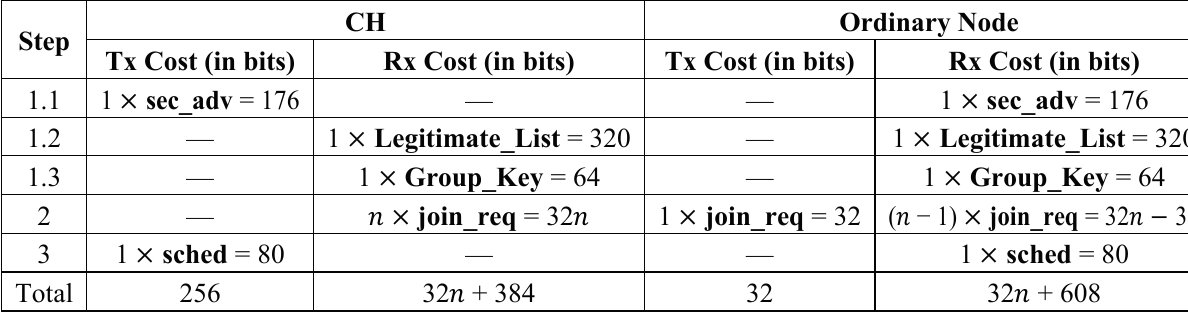
Table 9. Communication cost of SLEACH in setup